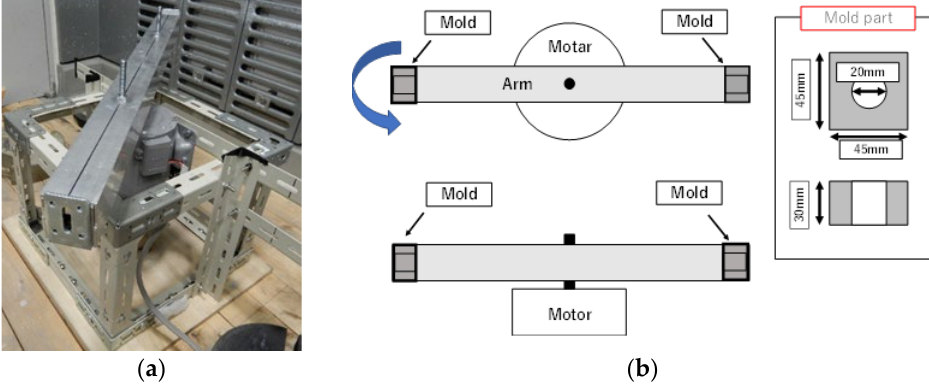
Figure 2. Set-ups of a centrifugal slurry equipment, ( a ) apparatus photo, and ( b ) schematic illustra- tion.